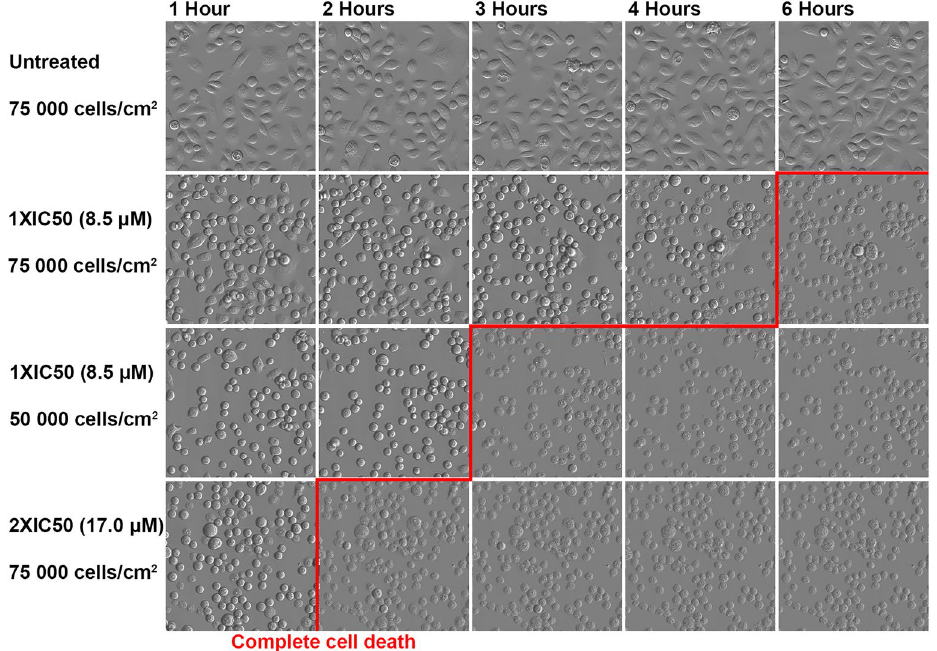
Figure 3. The rate at which MPM-1 kills cells is dependent on concentration and cell density. HSC-3 cells were seeded at different densities, treated with 1xIC50 or 2xIC50 MPM-1, and subsequently imaged